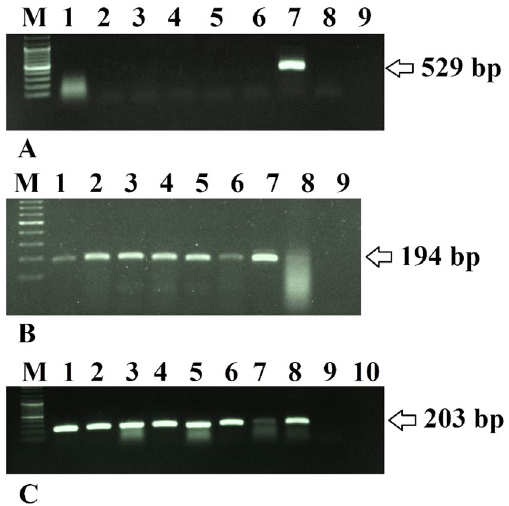
Figure 2. The absence of A. rhizogenes contamination was confirmed using PCR specific for virG . PCR amplification of a 194-bp fragment of rolB and a 203-bp fragment of hHAS2 using DNA and cDNA derived from hairy roots. (A) Lane M: 100 bp DNA ladder Mix (Thermofisher, USA), lanes 1–6, no fragment was amplified using DNA template extracted from transgenic hairy root lines; lane 7, PCR amplification of the 529- bp fragment of virG using A. rhizogenes plasmid as a positive control; lane 8, non-transgenic hairy root; lane 9, water as a negative control. (B) Lanes 1–6, DNA template extracted from transgenic hairy root lines showing the amplification of a 194-bp fragment of rolB ; lane 7, positive control (recombinant A. rhizogenes plasmid); lane 8, non-transgennic hairy root; lane 9, water as the negative control. (C) Lanes 1–7, cDNA template derived from transgenic hairy root lines showing the amplification of a 203-bp fragment of hHAS2 ; lane 8 positive control (recombinant A. rhizogenes plasmid) lane 9, water as a negative control; lane 10, cDNA template derived from a non-transgenic hairy root.